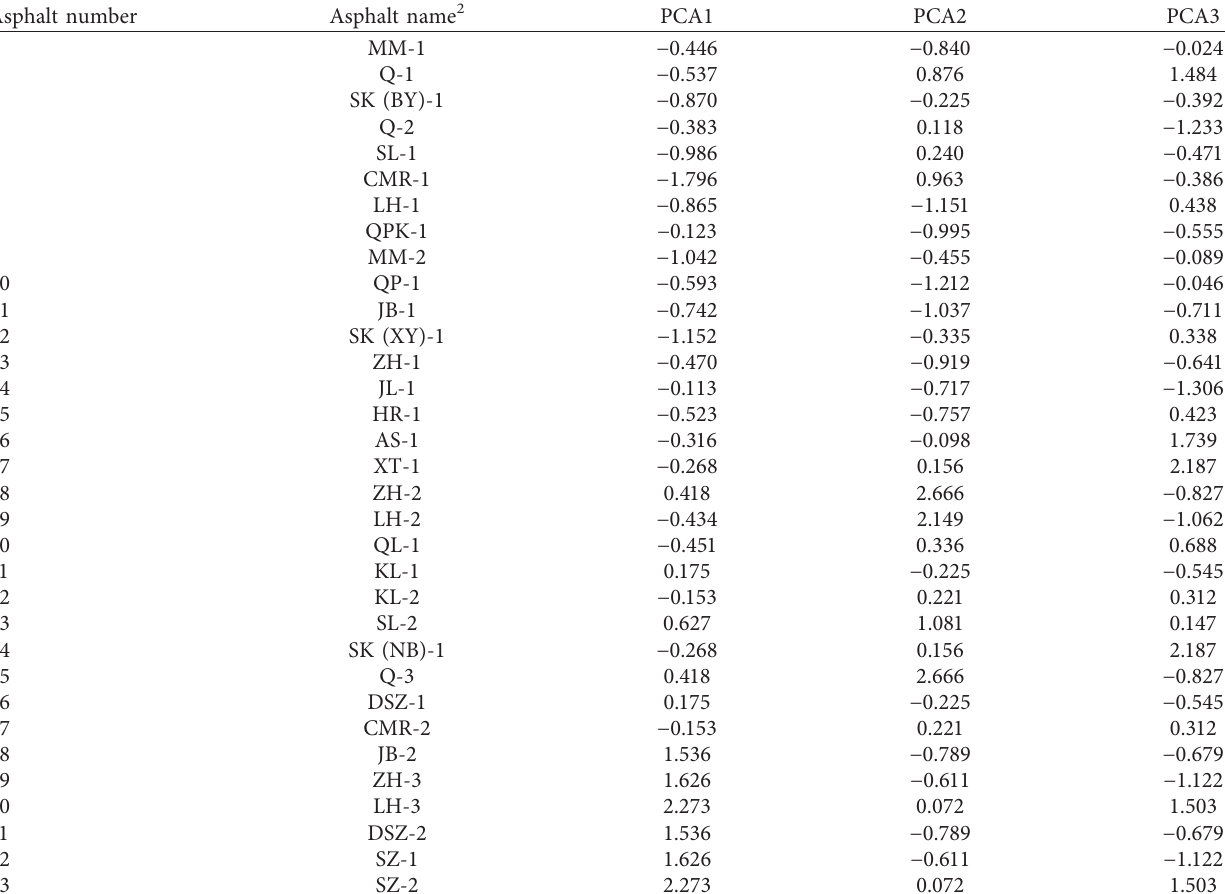
Table 7: The scores of each principal